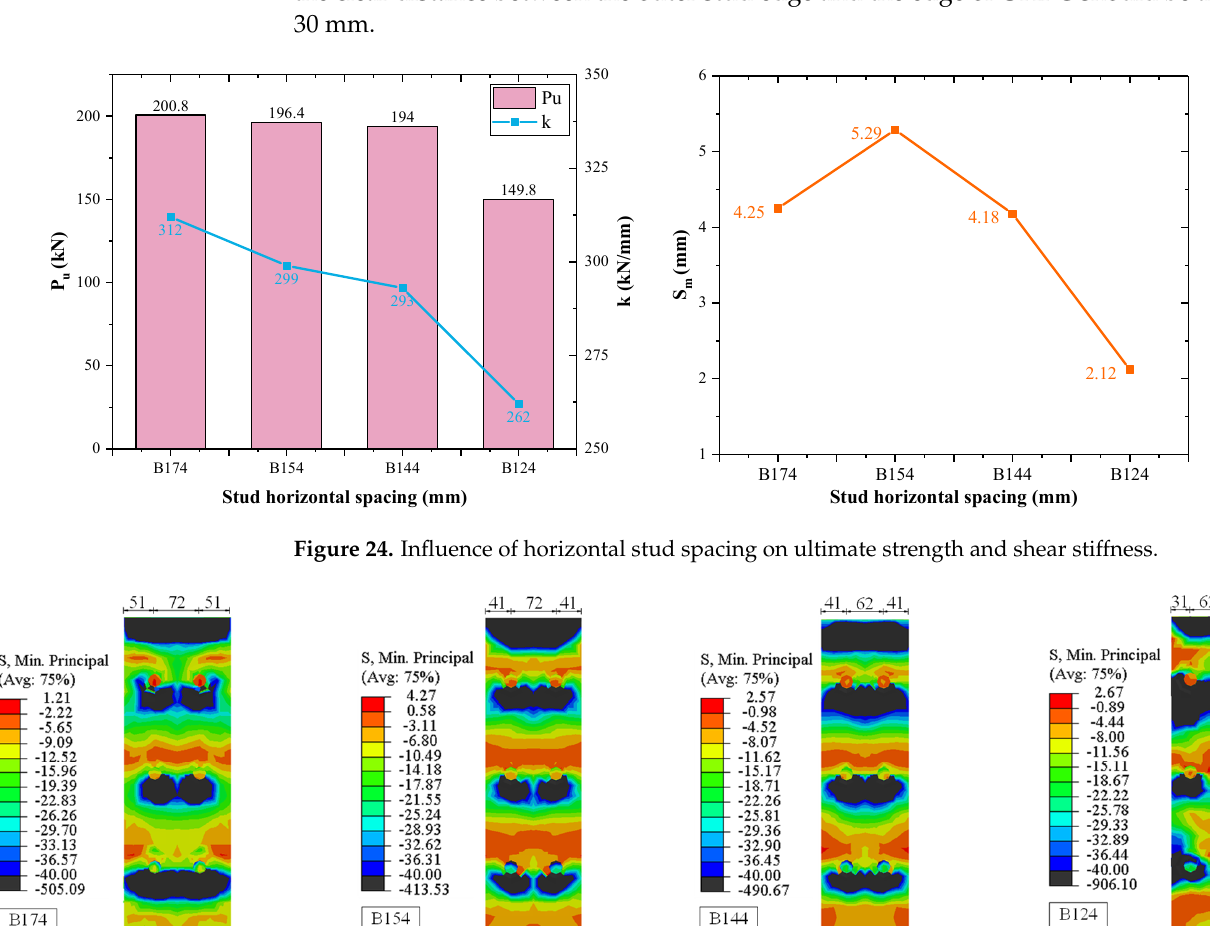
Figure 23. Load-slip curves of specimens with different stud horizontal spacing.